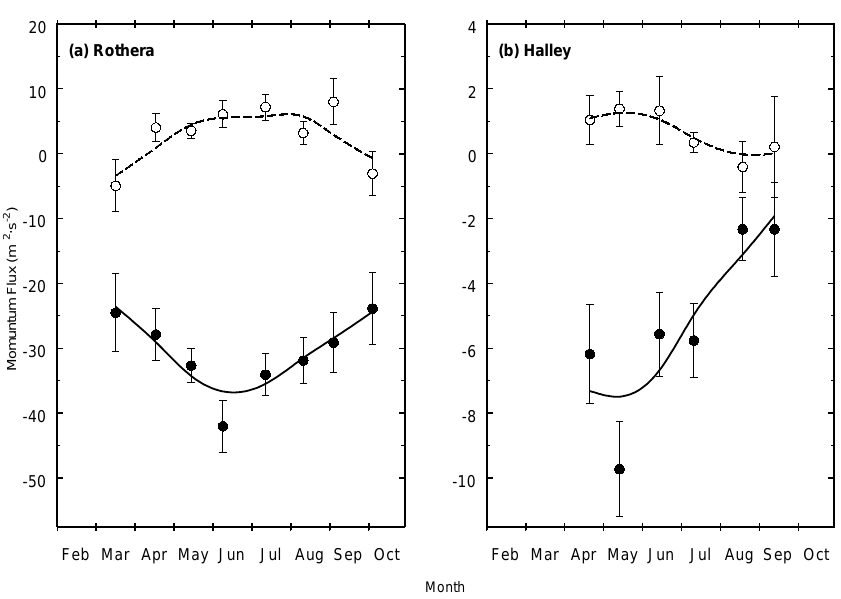
Fig. 5. The monthly average zonal (solid circles) and meridional (open circles) momentum fluxes from Rothera (a) . Also shown in (b) are the monthly averages from Halley, on a vertical scale 5 times smaller than the Rothera results. The solid and dashed lines are weighted least-squares fits to the zonal and meridional data,